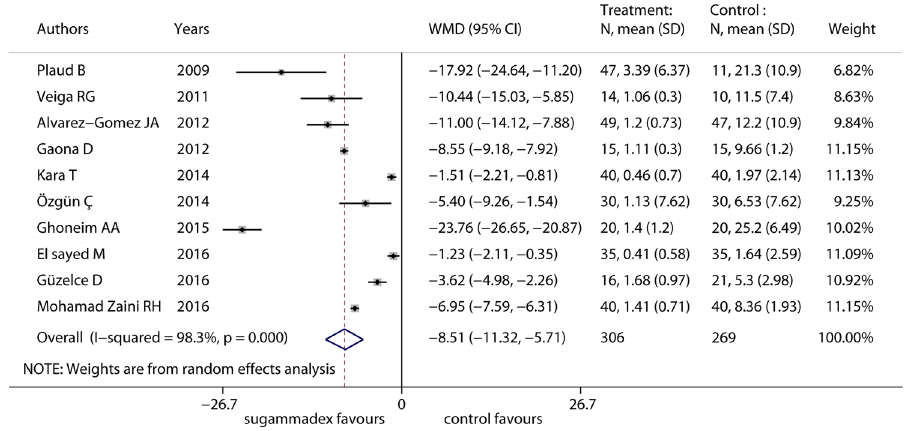
Figure 3. Forest plot of primary outcome of included RCTs. Sugammadex was significantly more effective than control in reducing recovery the reversal of neuromuscular blockade to TOFr > 0.9 in pediatric patients (WMD = − 8.51, 95% CI: − 11.32 to − 5.71), but considerable heterogeneity was detected (I 2 = 98.3%).